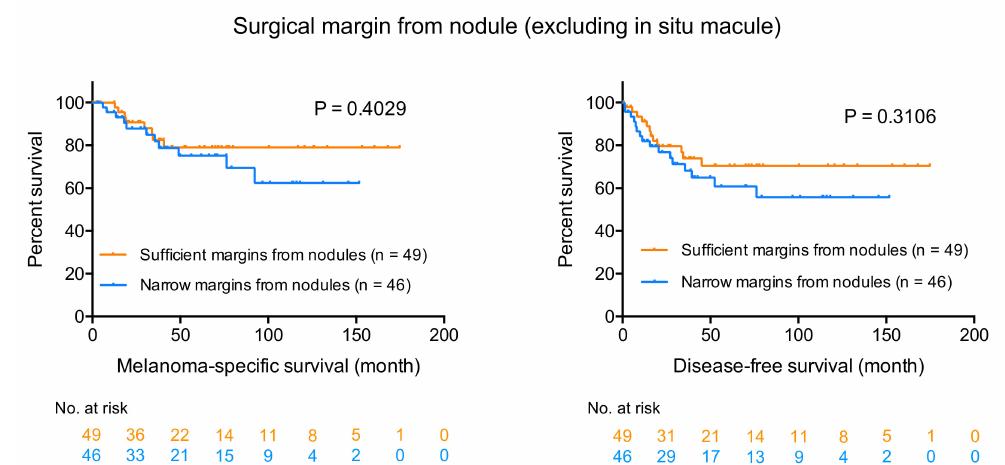
Figure 4. Kaplan-Meier survival curves of the “su ffi cient-margins from nodules” group and the “narrow-margins from nodules” group. Although the survival curves of the narrow margin group are under those of su ffi cient margin group, there is no statistical di ff erence between the groups with su ffi cient and narrow margins ( p = 0.4029 for MSS, and p = 0.3106 for DFS).